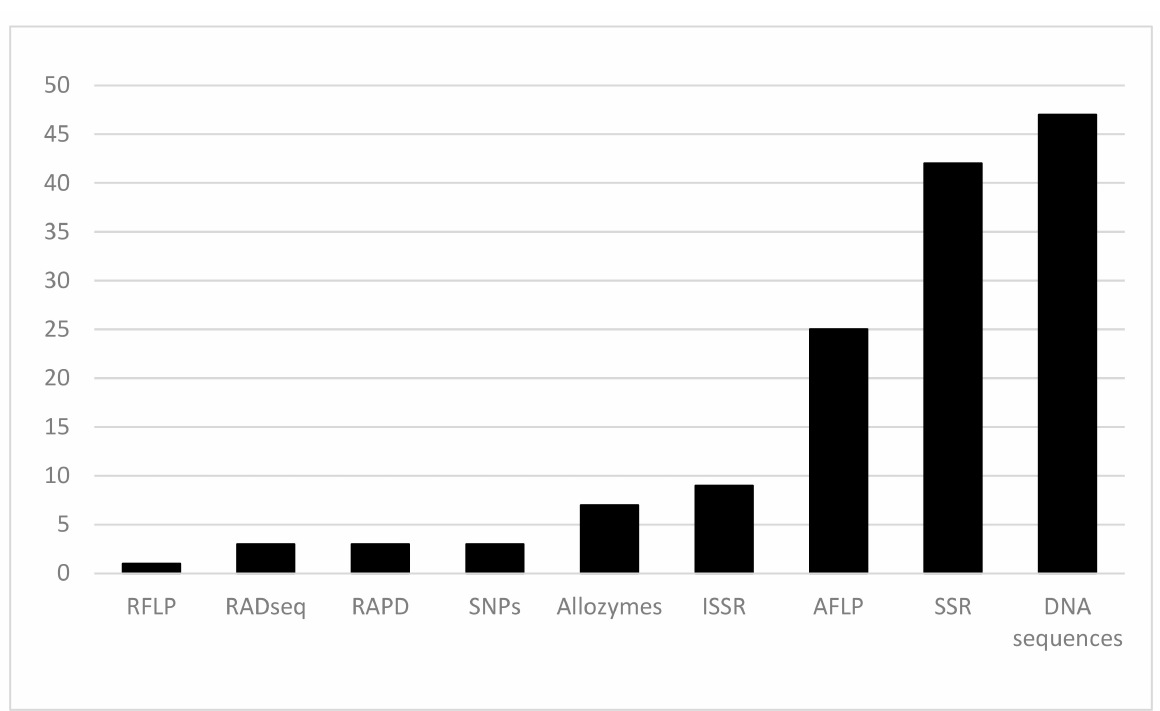
Figure 4. Graph showing the number of times that the different genetic methodologies have been used in order to propose species conservation measures regarding the phylogeographic